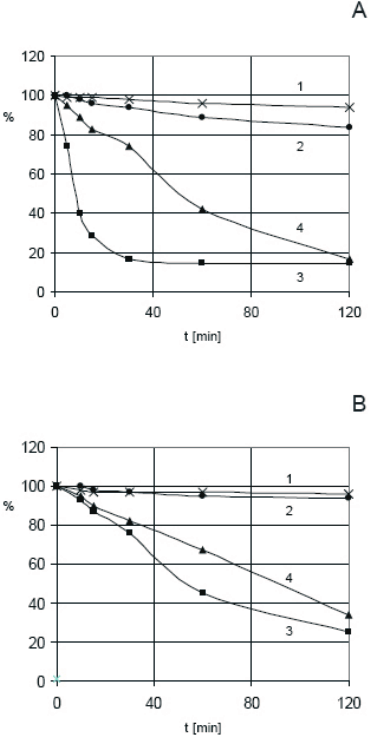
Figure 2. Time stability of solutions containing 2.4 µg mL -1 DHCHE in aqueous methanol (A) and ethanol (B) media and measured at 274 nm. Alcohol content (in % v/v): 1 – 4%; 2 – 10%; 3 – 30%; 4 –